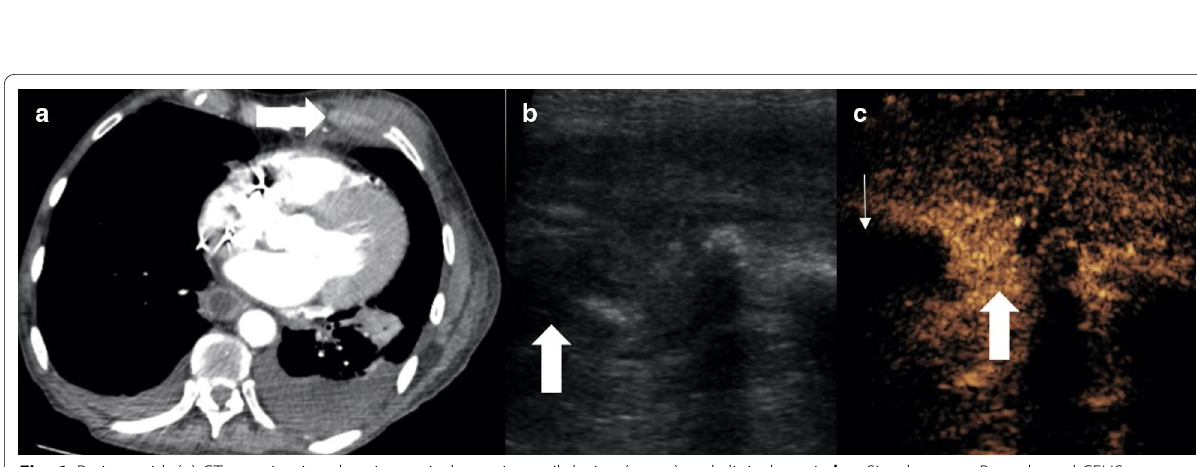
Fig. 6 Patient with ( a ) CT examination showing an indeterminate rib lesion (arrow) and clinical sepsis. b , c Simultaneous B mode and CEUS better defined the lesion which was not well seen on B‑mode ultrasound imaging (arrow) into a solid hyperenhancing component (thin arrow) and central avascular component (thick arrow). Fluid aspiration yielded pus of the fluid component and the biopsy was inflammatory indicating